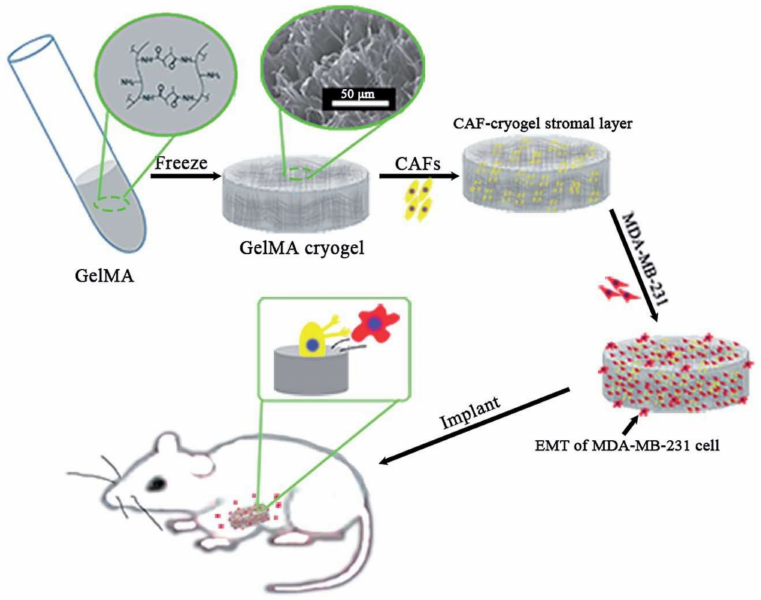
Figure 11. The co-culture system for the role of carcinoma-associated fibroblasts in the epithelial–mesenchymal transition process of human breast cancer cells in vitro and in vivo. Republished with permission from [70]. Copyright 2017 the Royal Society of